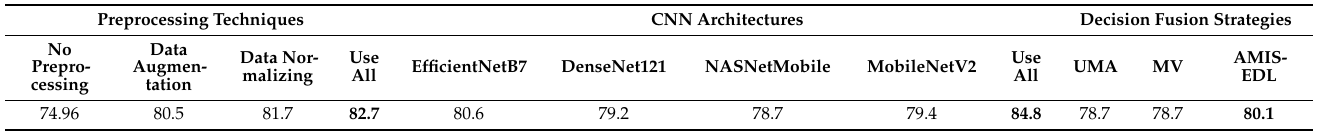
Table 7. Percentage average accuracy value of using different strategies of the data presented in Table 6.